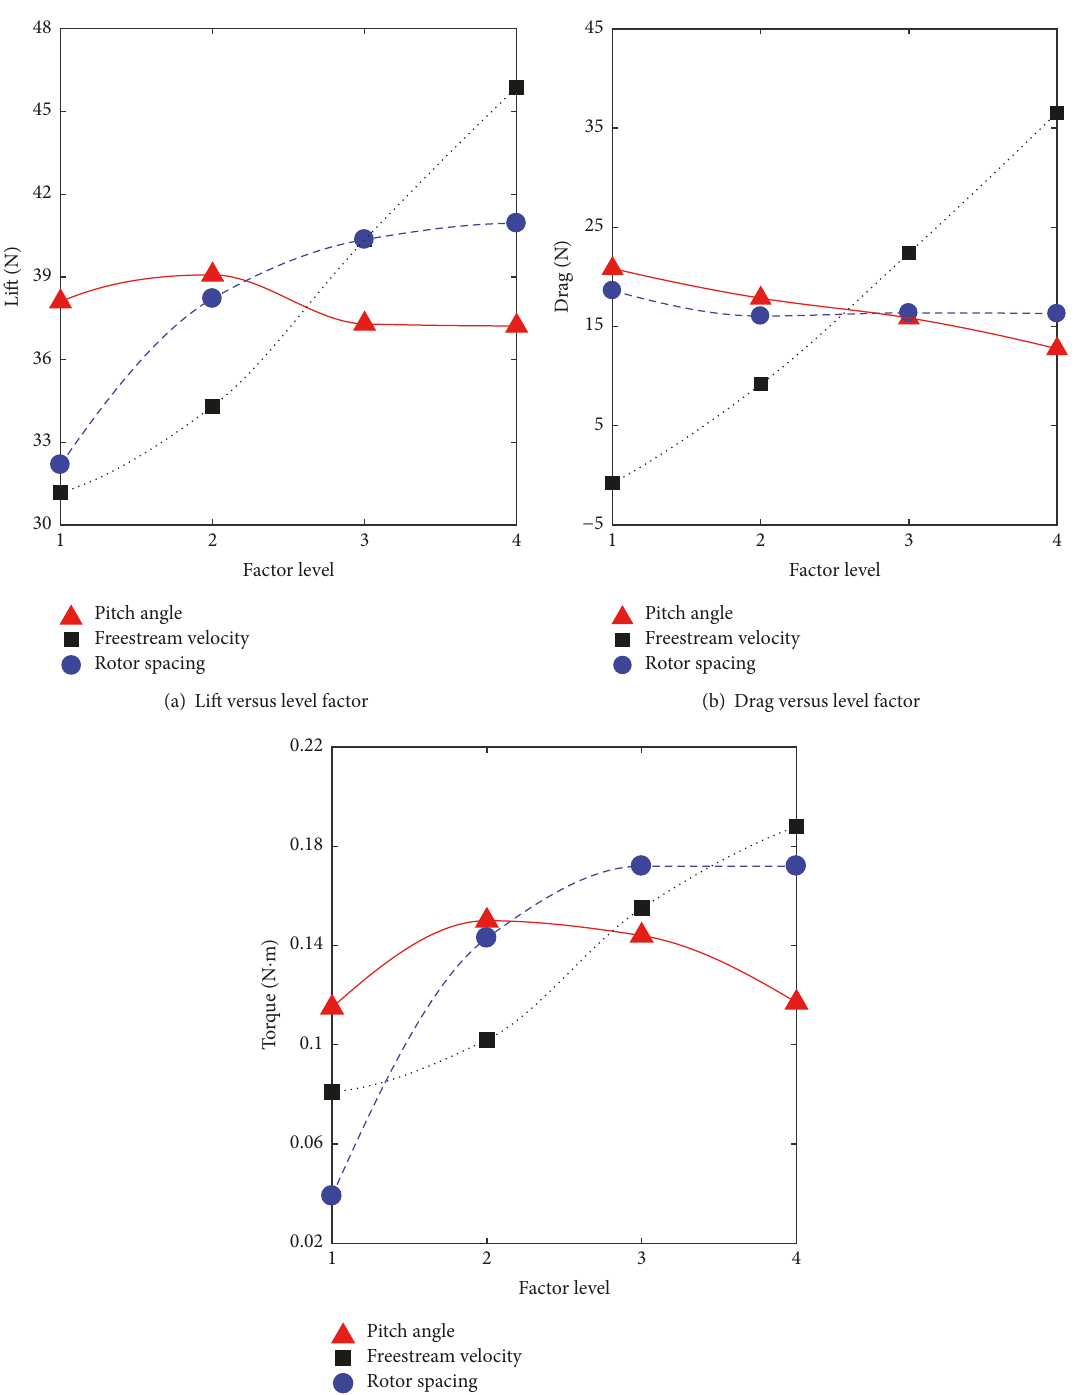
Figure 10: Trend of forward flight aerodynamics with diverse factors.